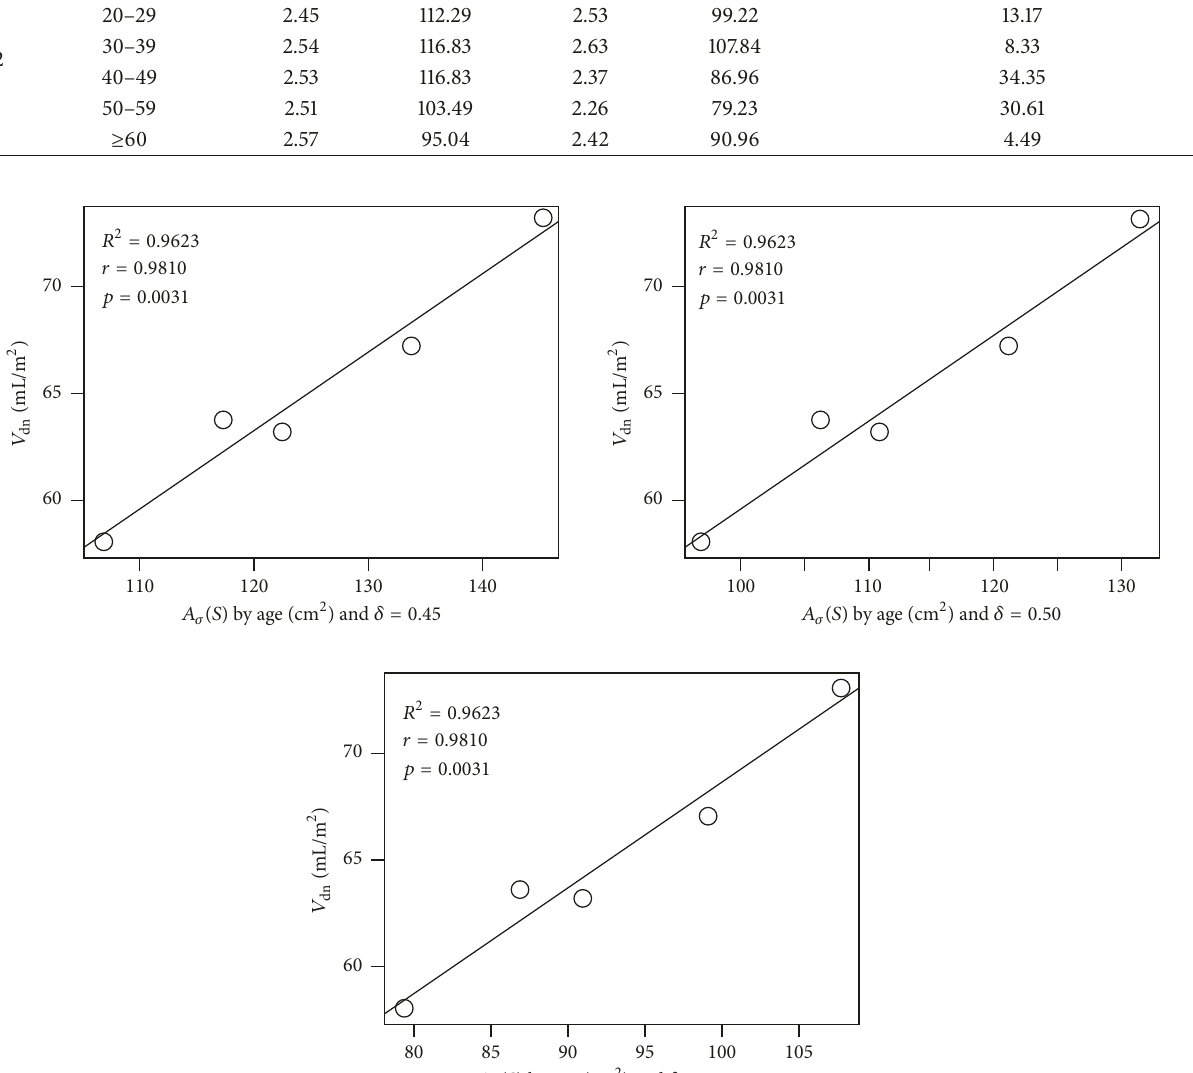
Figure 5: Dispersion and linear regression between the average surface area of LV and the end-diastolic volume normalized by the body area of women per age